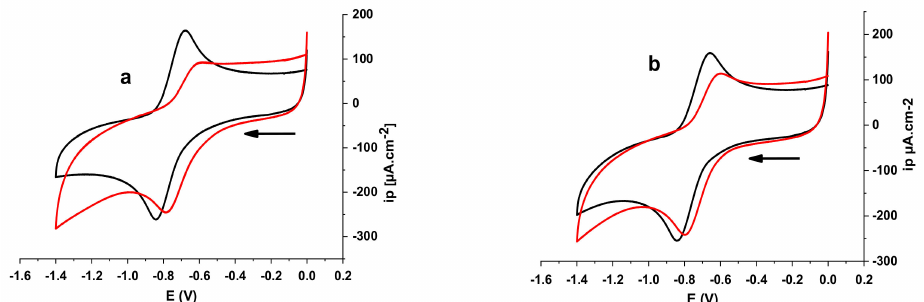
Figure 13. Cyclic voltammograms of O 2.- on a polished Pt electrode in the absence (black line) and presence of algal polysaccharidic extracts in DMSO solution with supporting electrolyte 0.1 M Bu 4 NBF 4 at 100 mV · s − 1 : ( a ) 0.6 mL of E 2 ; ( b ) 0.5 mL of E 3